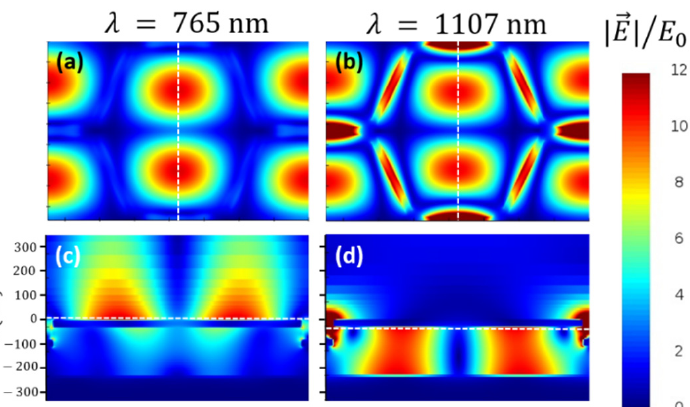
Figure 3. Near-field distributions associated with the SLR at 765 nm ( a , c ) and 1107 nm ( b , d ). ( a ) and ( b ) correspond to in-plane views 10 nm above and below the inverted honeycomb lattice, respectively, at the heights indicated by the dashed lines in the corresponding panels ( c , d ). ( c , d ) depict transversal cross sections of the heterostructure along the dashed lines plotted in the corresponding in-plane view panels ( a , b ), respectively. E | / E 0 stands for the normalized modulus of the electric field with respect to the modulus of the incident radiation.